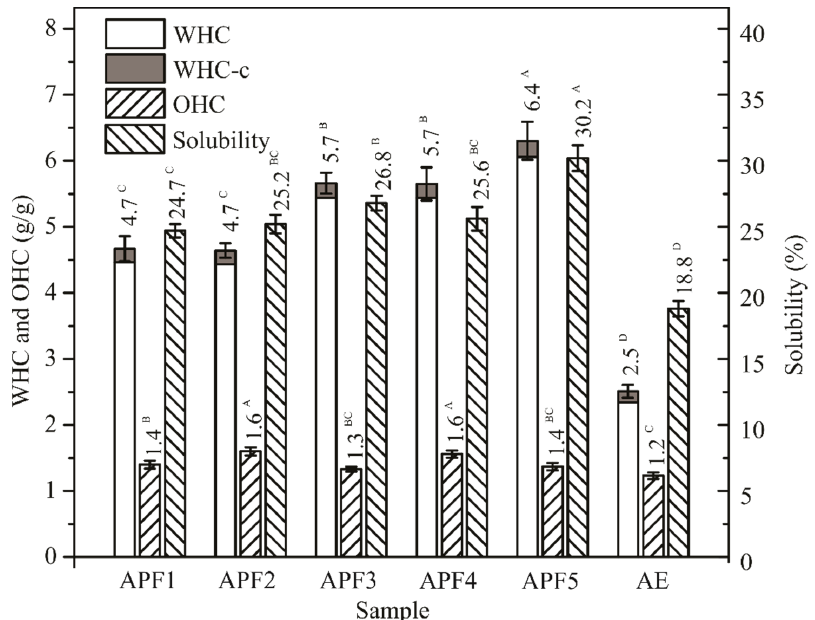
Figure 1. Water holding capacity (WHC) corrected for contribution of the soluble part of the APF (WHC-c), solubility and oil holding capacity (OHC) of APF samples in comparison to most similar commercially available products (AE). Data were subjected to one-way ANOVA (between-subjects factor: type of APF ( n = 3); six levels: APF1, APF2, APF3, APF4, APF5 and AE; degree of freedom for both parameters was 5; for WHC F = 135.4 and p < 0.001, for OHC F = 20.9 and p < 0.001), different superscripts within the same parameter indicate a significant difference of means, according to Tukey’s HSD test ( p < 0.05).